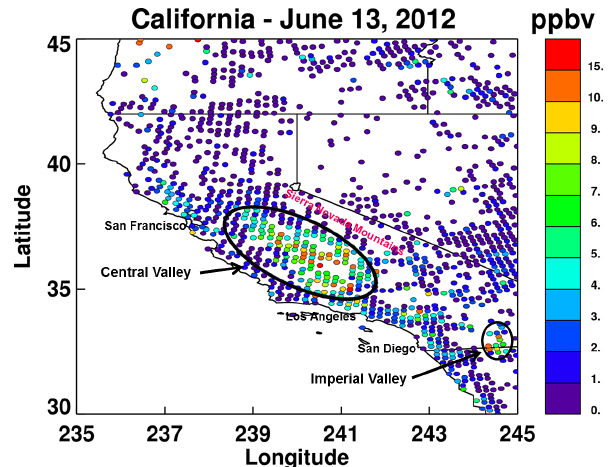
Figure 11. CrIS NH 3 VMR retrievals over California, USA, on 13 June 2012. The VMR values are at the peak CrIS retrieved ver- tical sensitivity level based on the averaging kernels, which is typi- cally in the boundary layer (900–750hPa or